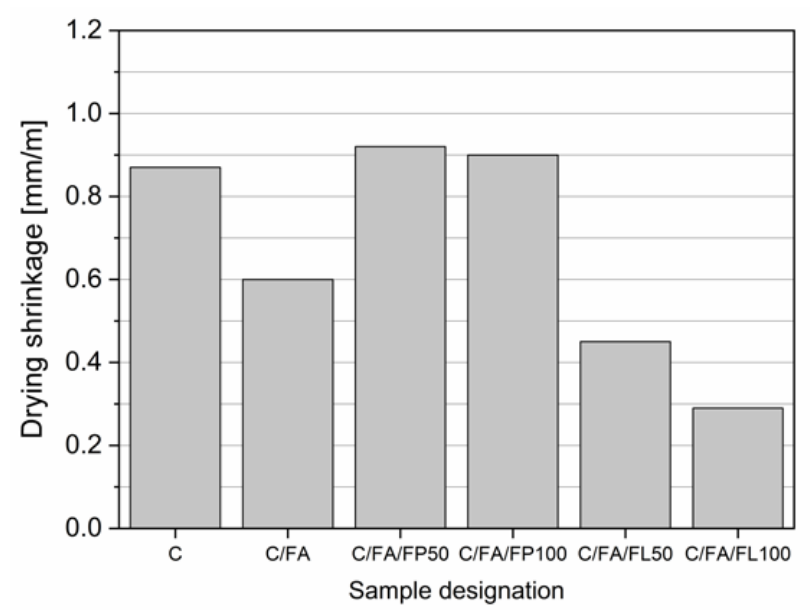
Figure 5. Drying shrinkage of foamed concrete mixes at 28 days.